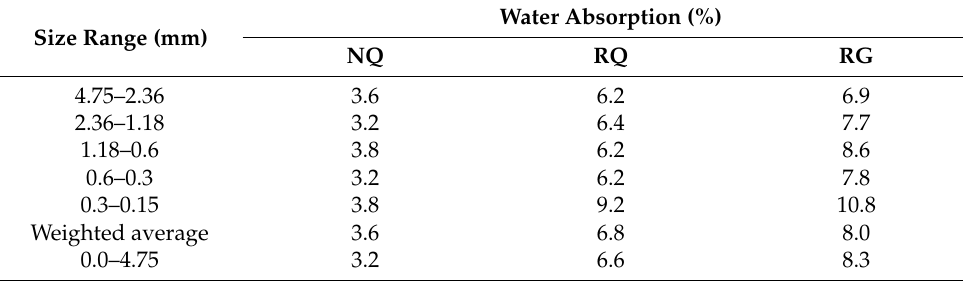
Table 2. Water absorption results for electrical method.